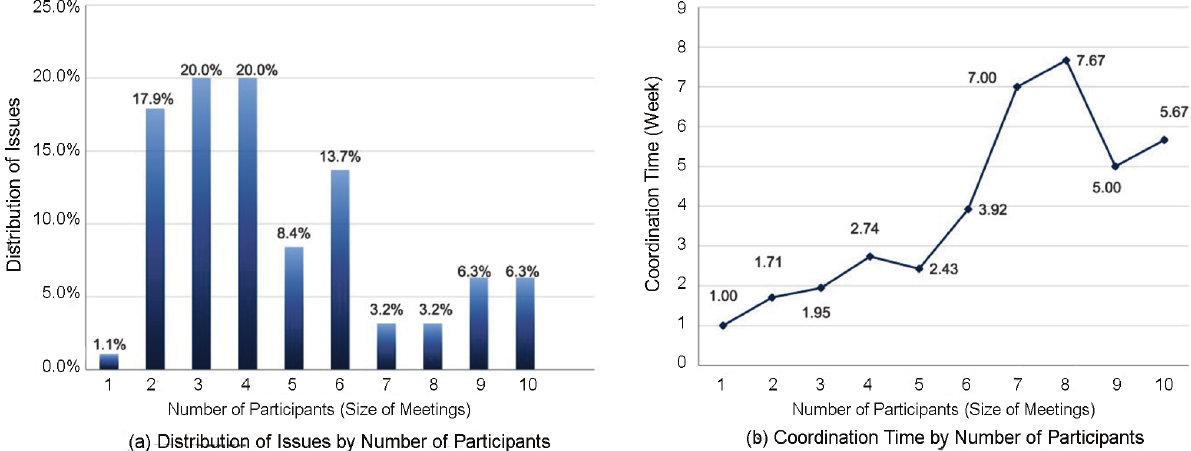
Figure 7. Distribution of issues and coordination time by the number of participants